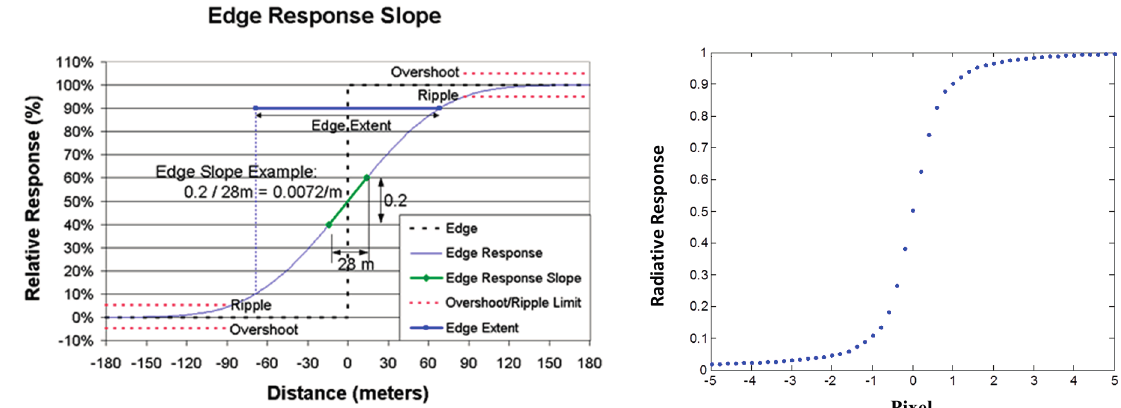
Figure 10. ( Left ) Graphics demonstrating the definition of RER and HEE. ( Right ) Measured instrument response for a representative pixel in the 12-micron channel (TIRS Channel 11). In the graph, each pixel represents 100